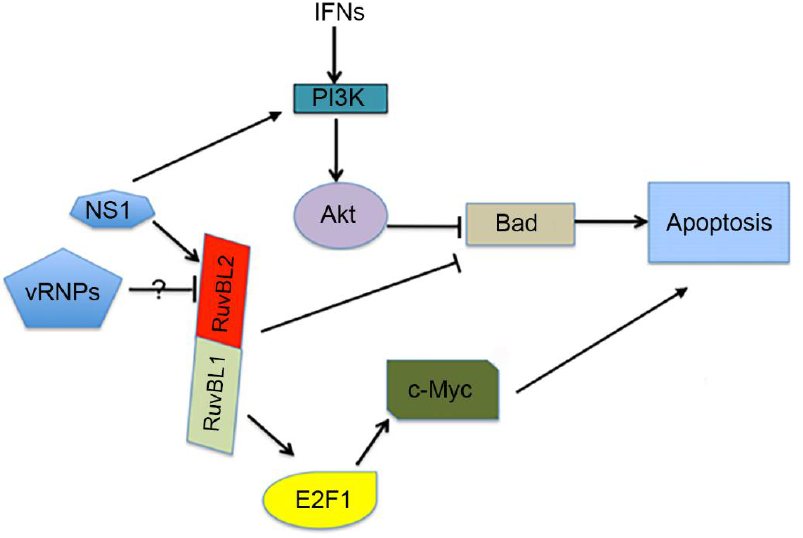
Figure 9. A proposed model underlying the regulation of apoptosis by RuvBL2 in IAV-infected cells. IAV infection suppresses cellular RuvBL2 protein abundance via a non-NS1 viral element(s) (poten- tially vRNPs), and reduction in RuvBL2 protein abundance induces apoptosis potentially through